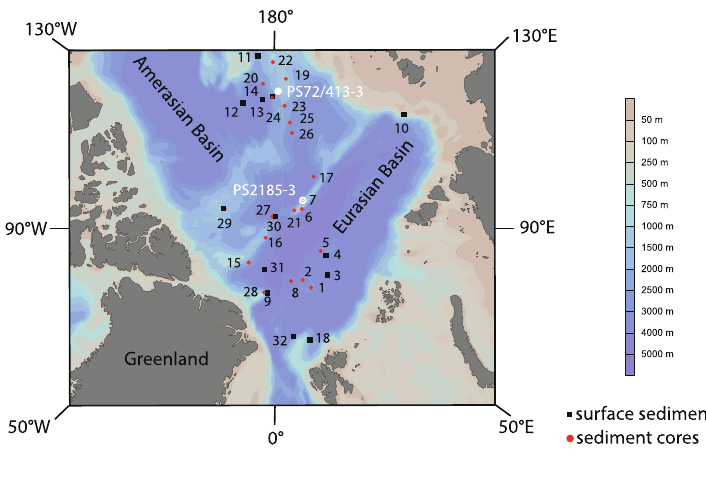
Fig. 1 Map with the investigated core sites (see Supplementary Table 1 for the core locations). Studied sediment cores (white), sediment records whose chronologies are probably affected by overgrowth (red). Surface sediments with overgrowth on foraminifer specimens (black). Bathymetric map created by Ocean Data View version 5.6.2 98